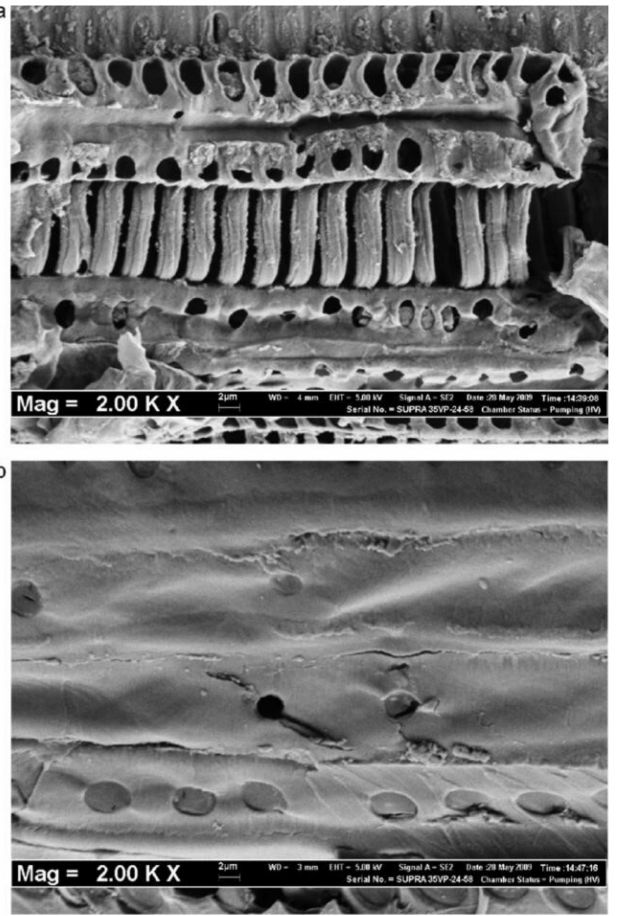
Figure 7. ( a ) NaOH-modified rejected tea (N-RT) before dye adsorption and ( b ) NaOH-modified rejected tea (N-RT) after dye adsorption